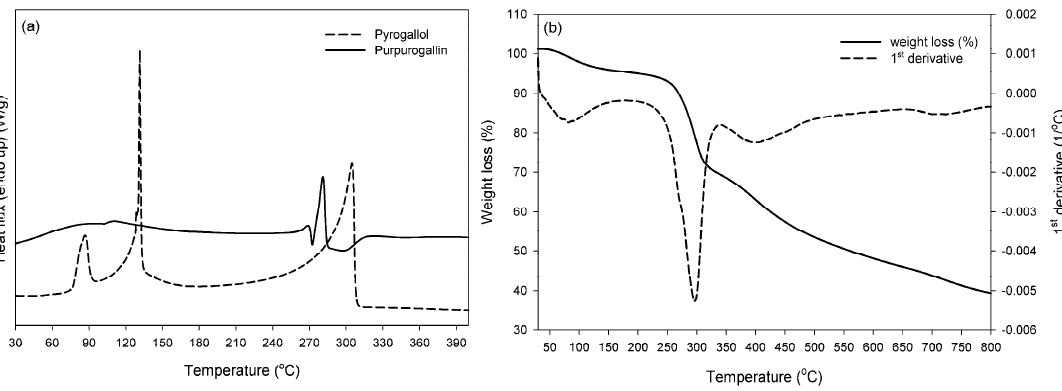
Figure 6. Thermal analysis curves ( a ) DSC and ( b ) TGA of enzymatically synthesized purpurogallin.